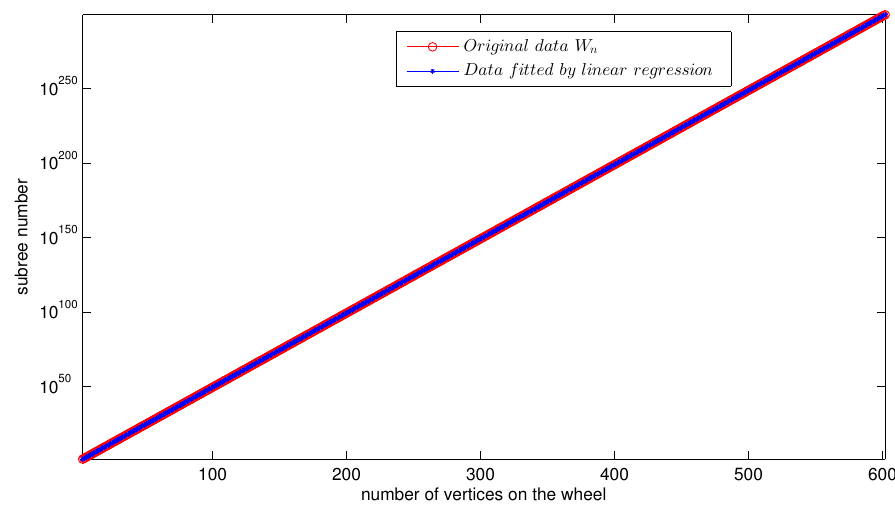
Figure 5. Subtree number trend of wheel graph W n ( n = 3,4, . . . ,602 ) , in semi-log(Log-Y)